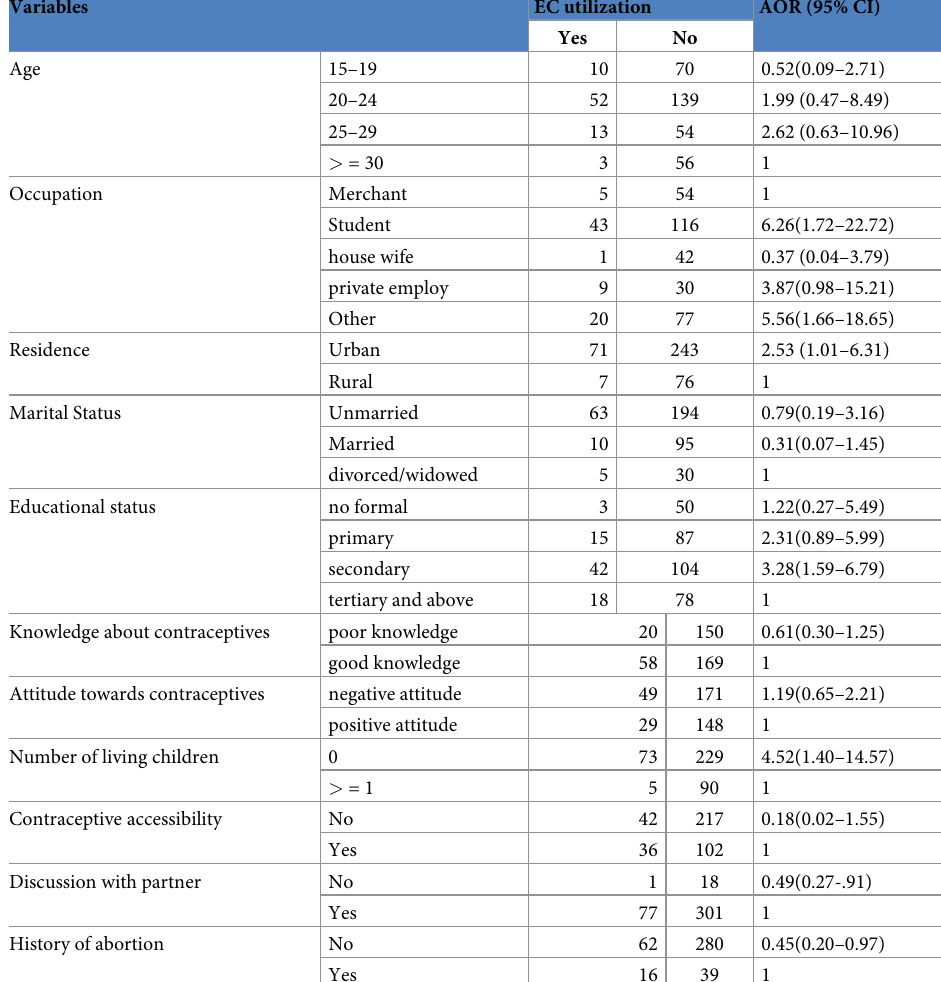
Table 3. Factors associated with emergency contraceptive utilization among 397 women seeking termination of pregnancy, Northwest Ethiopia,